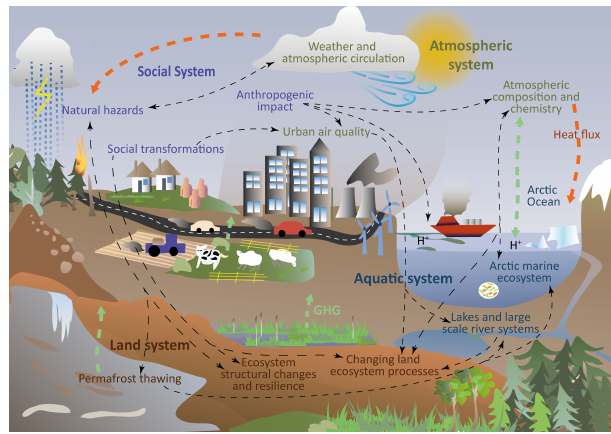
Figure 1. The thematic research areas relevant to the Northern Eurasian land system include land topic 1 “changing ecosystem pro- cesses”, land topic 2 “ecosystem structural changes and resilience” and land topic 3 “risk areas of permafrost thawing”. For the atmo- spheric system they are atmosphere topic 1 “atmospheric compo- sition and chemistry”, atmosphere topic 2 “Urban air quality”, are atmosphere topic 3, “atmospheric circulation and weather”, for the aquatic system they are aquatic topic 1 “Arctic Ocean in the cli- mate system”, aquatic topic 2 “maritime ecosystems”, aquatic topic 3 “Lakes and large river systems”, and for the social system they are society topic 1 “natural resources and anthropogenic activities”, society topic 2 “natural hazards” and society topic 3 “social trans-